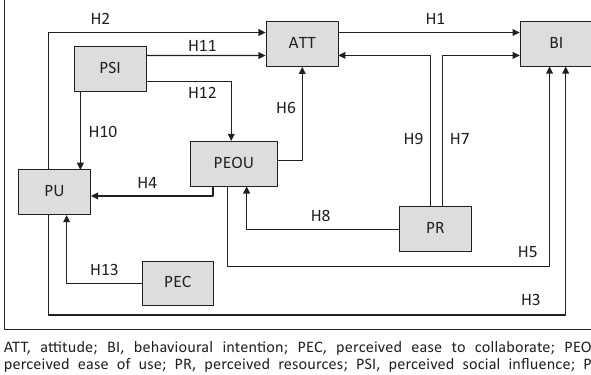
FIGURE 1: Hypothetical model of rural-based Science, Technology, Engineering and Mathematics learners’ and teachers’ acceptance of mobile